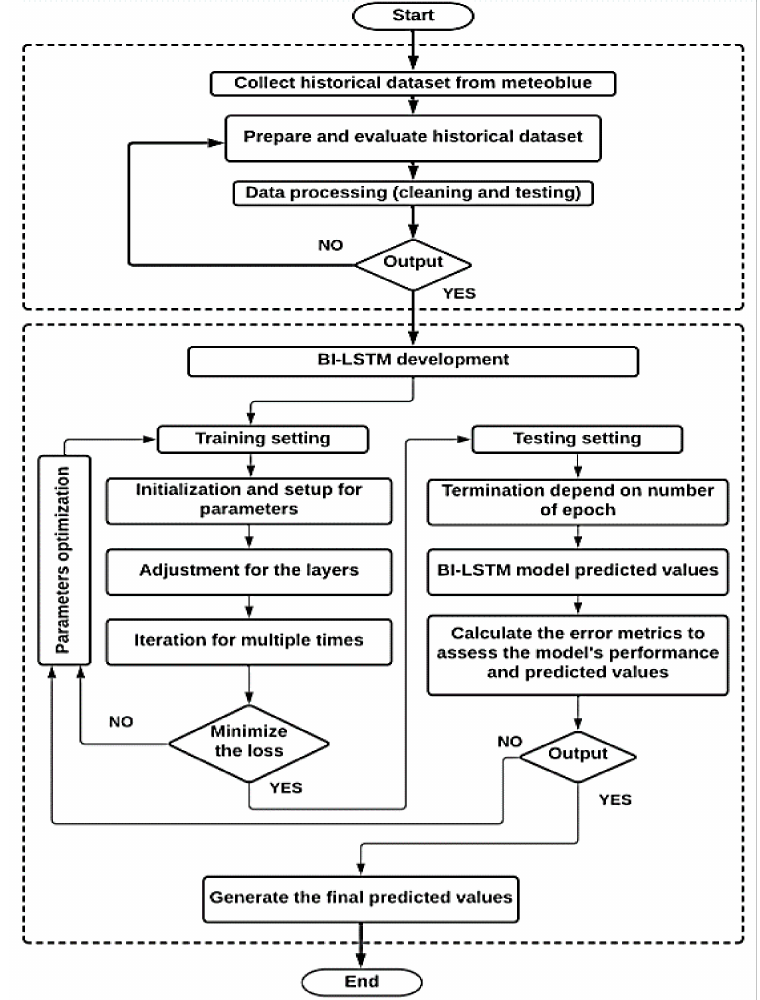
Figure 17. The flowchart of the proposed BI-LSTM